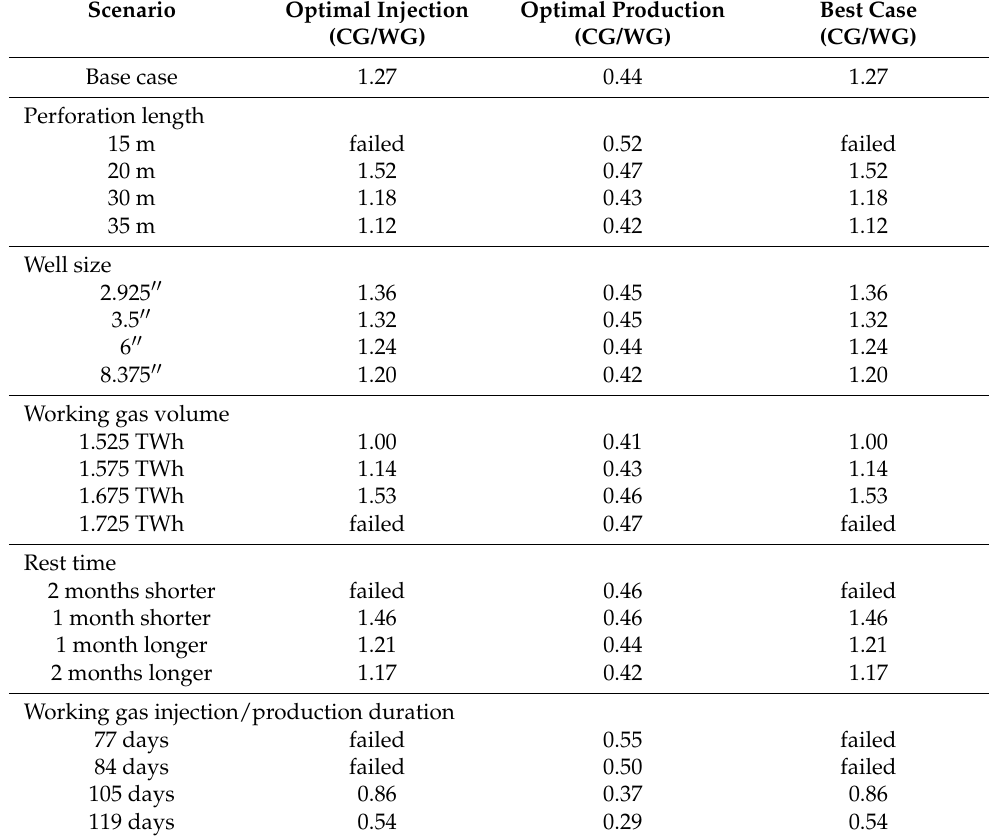
Table 3. Results of the